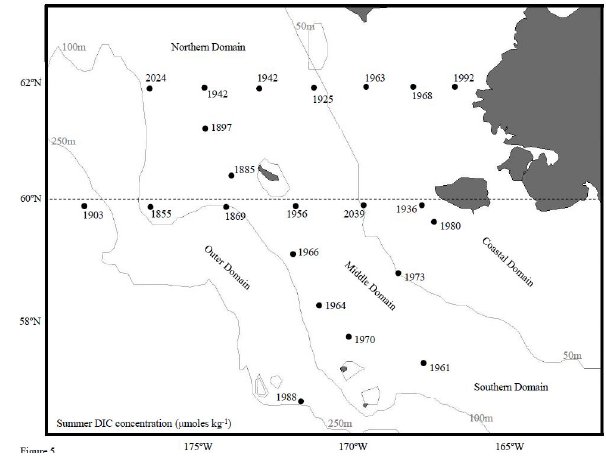
Fig. 5. Summer DIC concentrations (µmoleskg − 1 ) averaged over the upper 30m across the